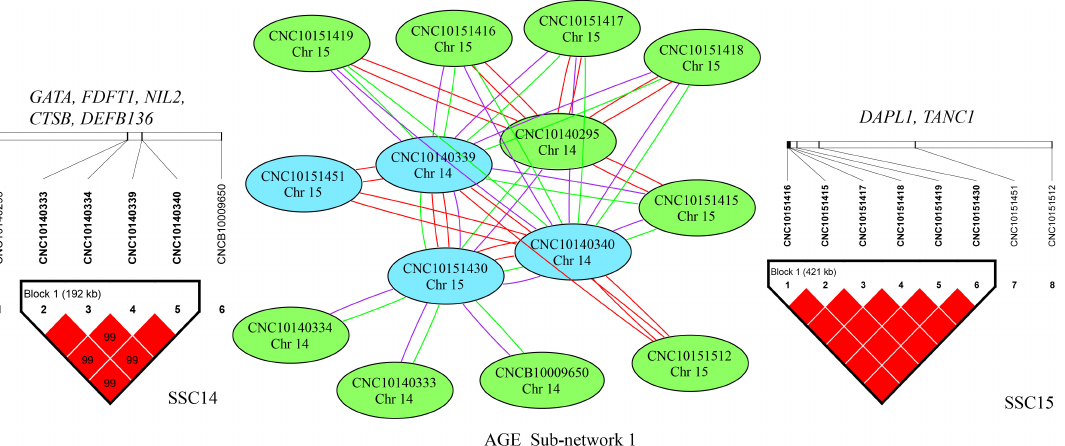
Figure 4. Epistatic sub-network 1 among SNPs affecting AGE and the related LD information. The color of a node represents the p -value of an interaction ( p < 1 × 10 − 12 = red; p < 1 × 10 − 11 = blue; p < 1 × 10 − 10 = green). The color of the connecting lines between circles indicates the type of epistatic effect (A × A = red; A × D = purple; D × D = green). The genes located in the LD regions are